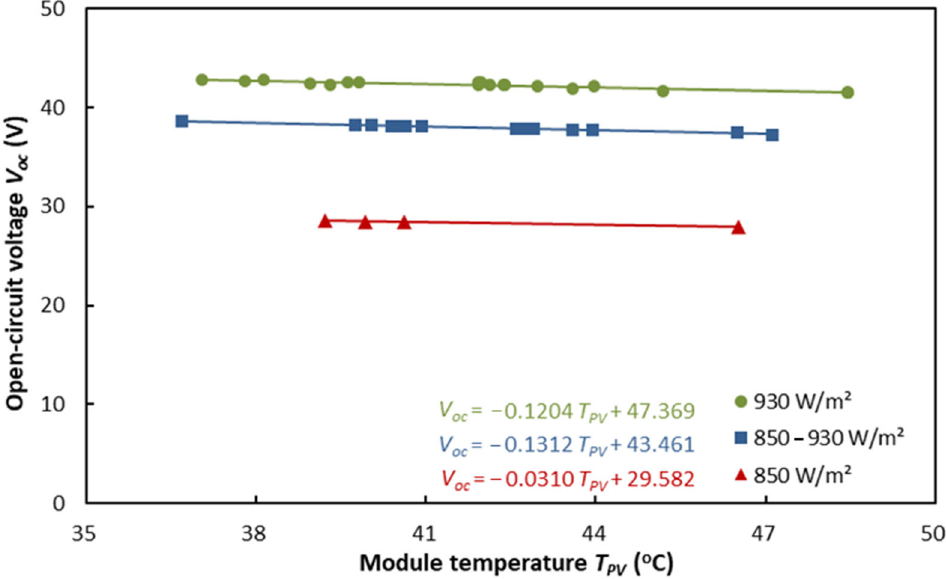
Figure 14. Outdoor open-circuit voltage as a function of module temperature under various irradiance levels.